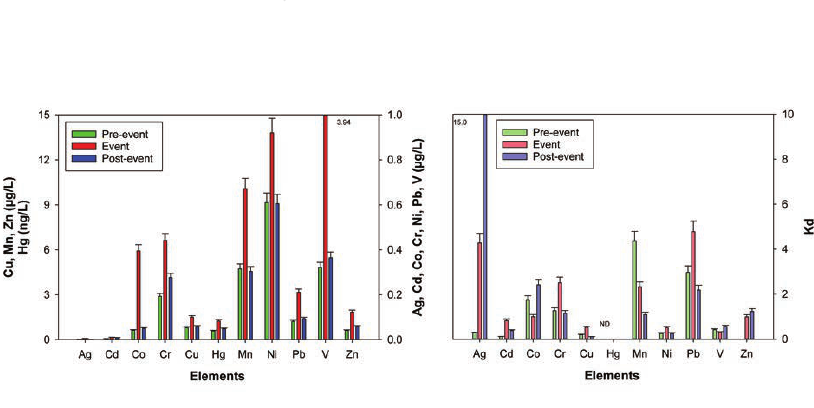
Figure 3. Total metal concentrations (left) and partitioning coefficient Kd (right) at fur- ther downstream (19 km) in the St. Lawrence river prior, during and after the